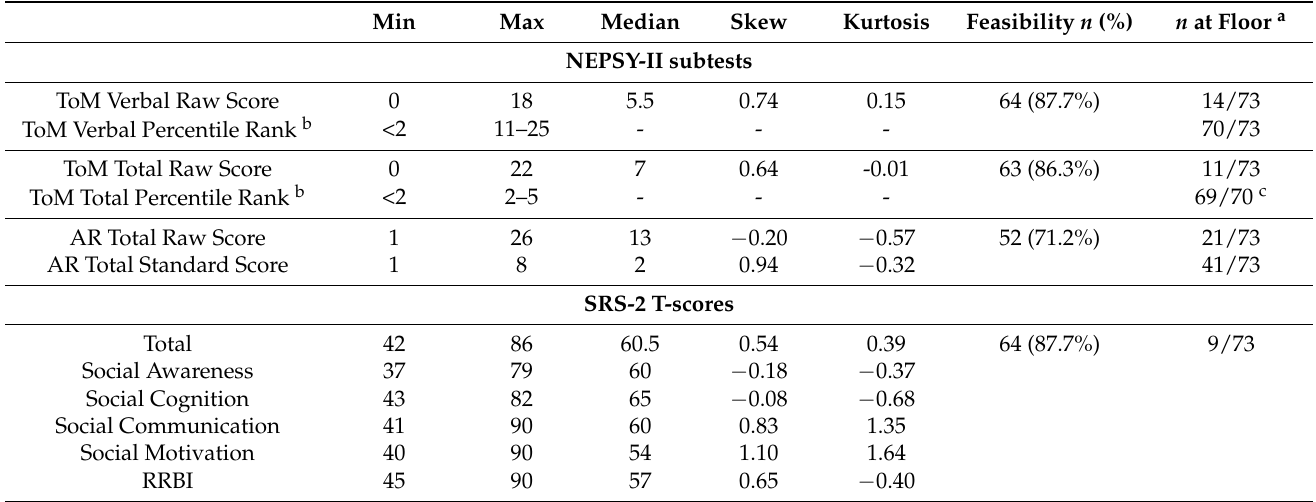
Table 1. Social cognition performance and feasibility at Time 1, n =